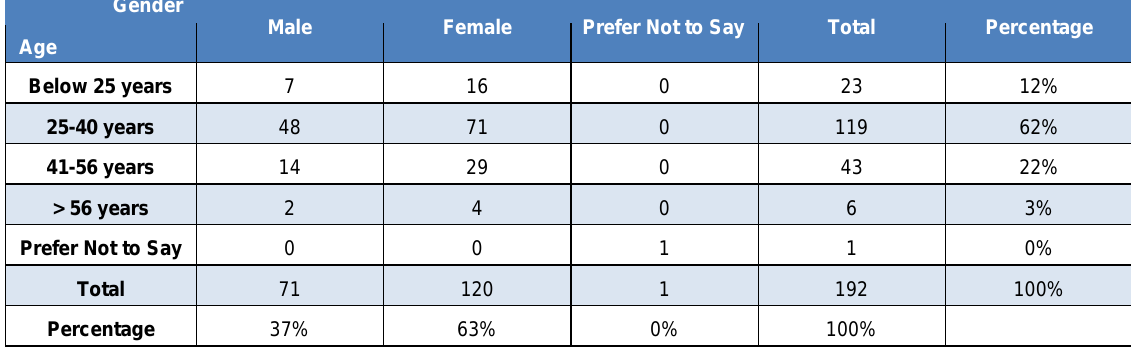
Data collection tools for ego